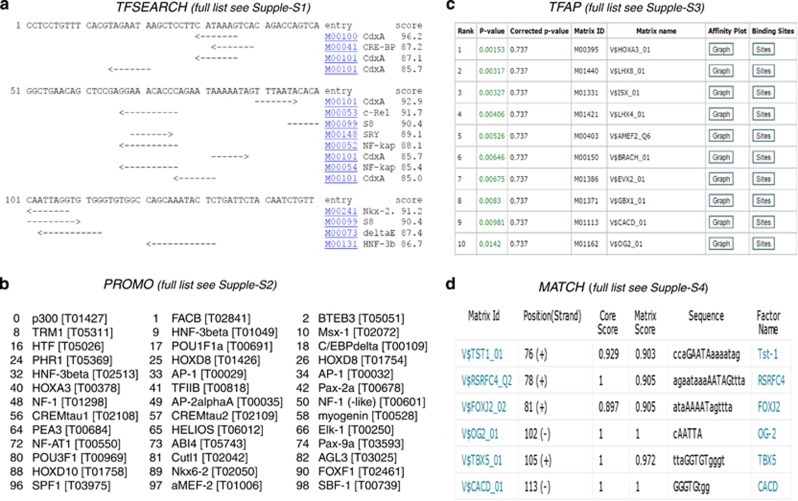
Bioinformatics prediction of TFBS within 150-bp Col10a1 cis-enhancer. (a) TFSEARCH with a cutoff score of 85 identified 15 putative TFBSs including CdxA (six times), C-Rel, S8 (twice) and Nkx-2 etc (see also Supplementary Data S1). (b) Promo 3.0 program (with 85 similarity) identified approximately 200 putative TFs, including many AP1s (c-fos, c-Jun, ATF and JDP families), Hif and αMEF-2 (see also Supplementary Data S2). (c) TRAP identified approximately 50 TFs that showed a P-value <0.05, including Hoxa3, CACD and αMEF-2 (see also Supplementary Data S3). (d) The MATCH program (with a matrix score of 90) identified six putative TFs including Tst-1, RSRFC4, FOXJ2, OG-2, TBX5 and CACD (see also Supplementary Data S4)